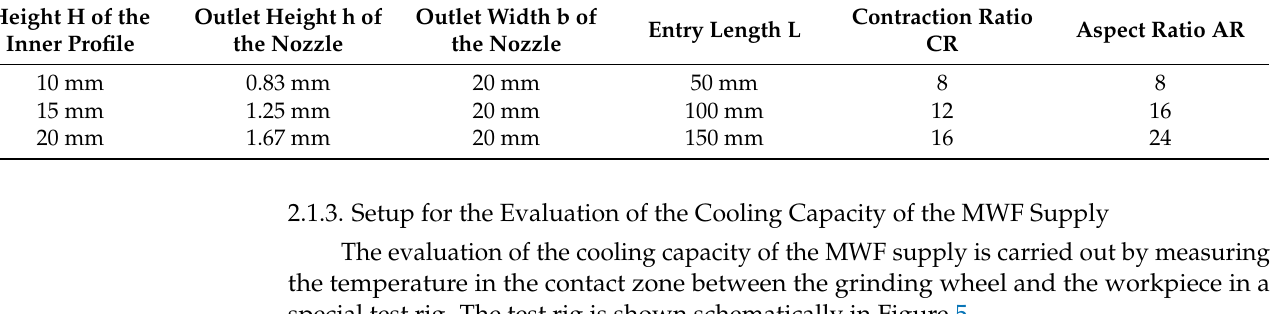
Table 1. Varied parameters of the nozzle geometry.